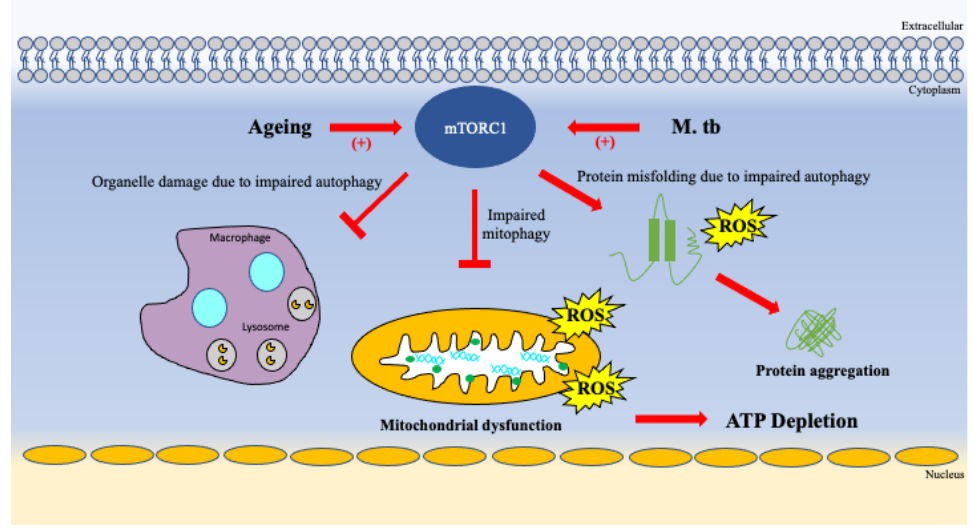
Figure 5. Ageing impairs ATP production, exacerbates buildup of protein aggregates and organelle damage.